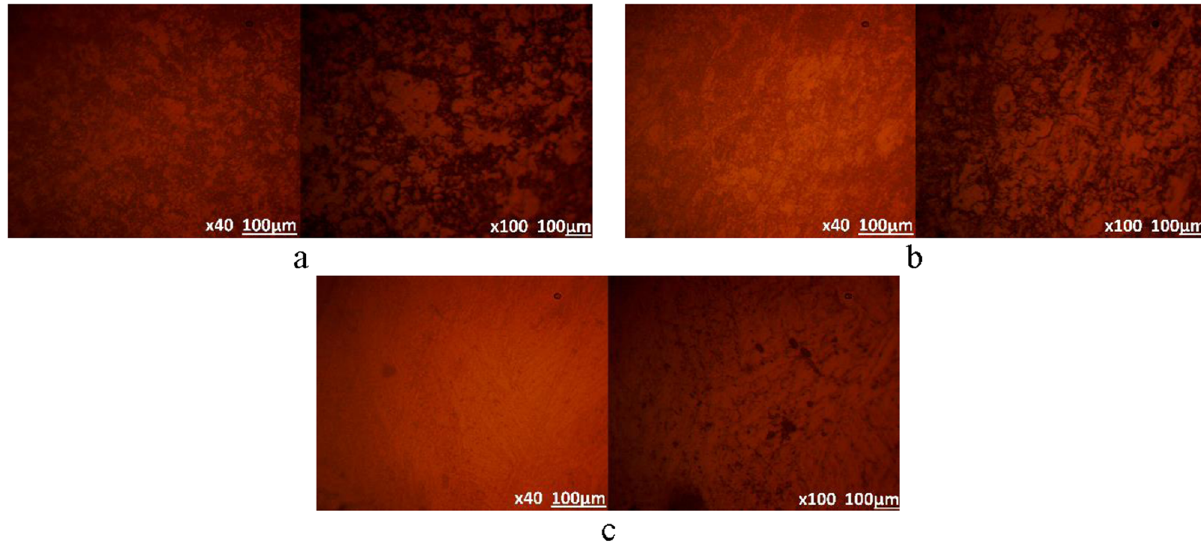
Figure 8: Optical images of ( a ) B265TiN, ( b ) B265TiQ, and ( c ) B265TiA after corrosion test in 2 M H 2 SO 4 + 10% NaCl at